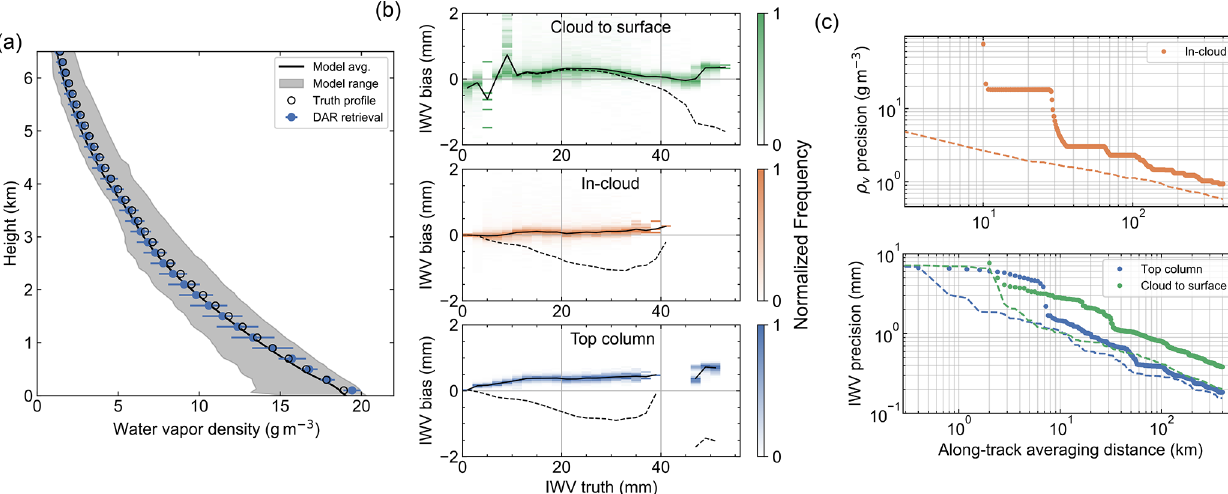
Figure 3. GATE DAR retrieval results for systematic (a, b) and random (c) error assessments. (a) Lower-tropospheric mean-retrieved water vapor profile (blue solid circles) compared with model values, including the full domain mean profile (solid black line), range of model humidity at each height (gray shaded region), and the conditionally sampled truth profile (black circles), which is calculated using only grid cells for which the DAR retrieved a 200m resolution profile value. Note that the DAR retrieval error bars correspond to the standard deviation of mean-retrieved values (i.e., elements of ˆ x ) at each height and do not depict measurement uncertainty from random error. (b) Two-dimensional histograms of IWV bias from retrievals using H ρ = 2 . 5km as a function of truth IWV, for the three distinct DAR column retrieval types (top: lowest column between surface and last cloud return; middle: partial columns within/between cloud layers; bottom: uppermost column between top-of-atmosphere and first detected range bin). Each vertical histogram is normalized to have a peak value of 1 for display purposes. Solid black lines correspond to the median bias when using H ρ = 2 . 5km, while dashed lines are the same for H ρ = 1 . 5km. (c) Retrieval precision scaling with along-track averaging, where the in-cloud curves (top panel) correspond to a profiling height of 3.9km. For each LES case, this profiling height is chosen to lie well within the average cloud and precipitation volume to avoid sparse sampling near the lower and upper boundaries. Dashed lines correspond to an intelligently scanned radar (see text). Solid circles represent the humidity precision scaling for a hypothetical along-track path that pieces together nadir-pointing transects for x = 21 . 1, 42.3, 63.1, and